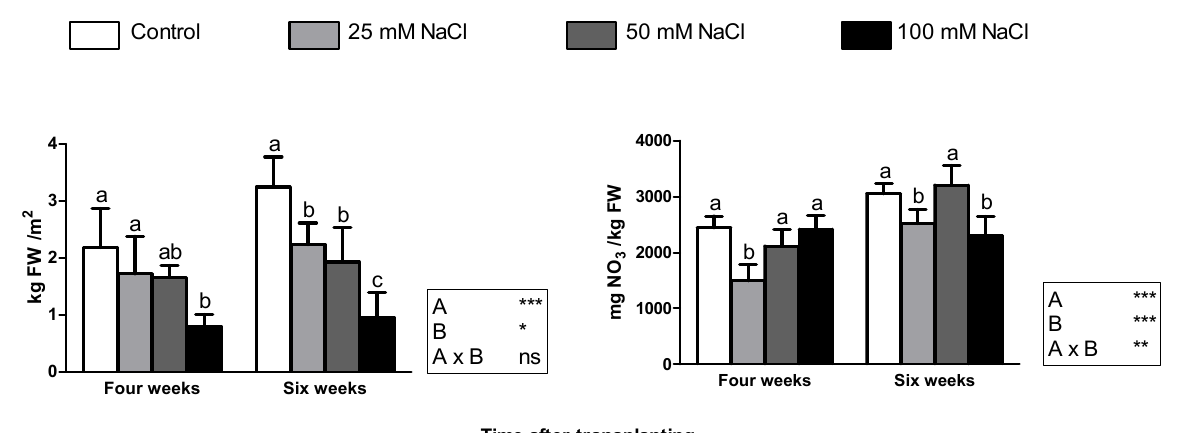
Figure 2. Crop yield ( left ) and leaf content of nitrates ( right ) in Reichardia picroides plants grown in floating system with different NaCl concentrations in the nutrient solution and sampled four and six weeks after transplanting. Mean values with standard deviation of four replicates. For each sampling date, different letters indicate significant differences at p < 0.05. The results of two-way ANOVA are reported in the right box: ***, significant at p < 0.001; **, significant at p < 0.01 *, significant at p < 0.05; ns, not significant. FW: fresh weight.